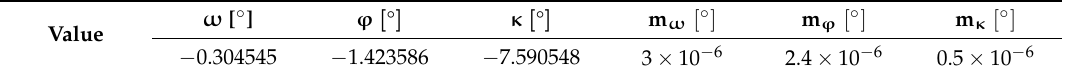
Table 12. Exterior (angular) orientation of sensor in field surveying and maximum errors.